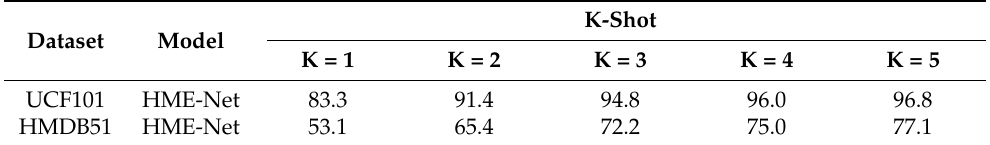
Table 4. Classification accuracy of 5-way K-shot where K ≥ 1 (Section 4.4.3) on UCF101 and